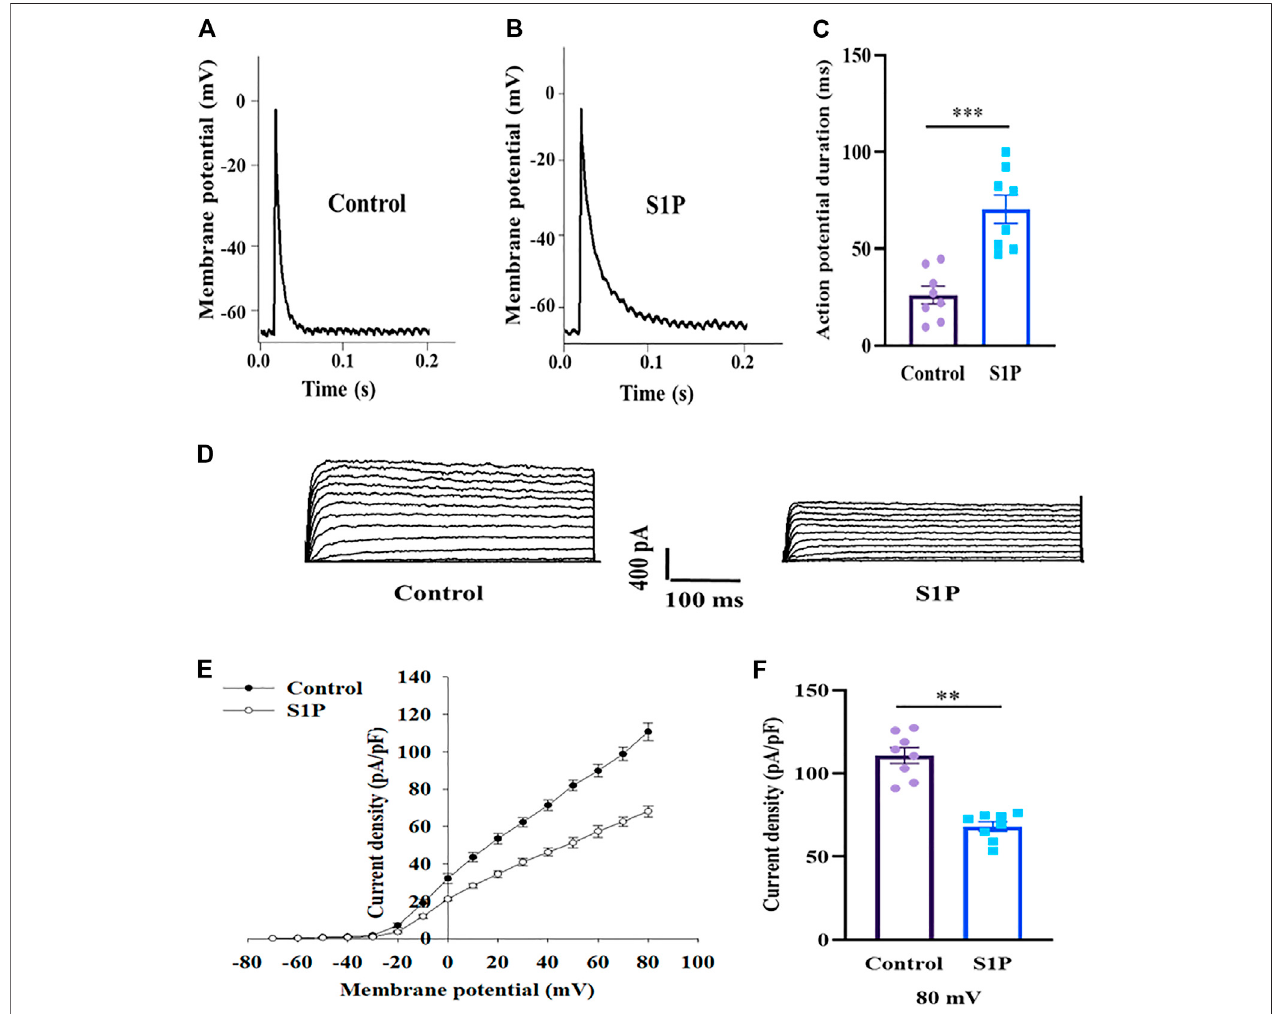
FIGURE 5 | Pancreatic β cells treated by sphingosine 1-phosphate (S1P) exhibited lengthened action potential duration (APD) and lower Kv currents. (A , B) Action potential waveforms of β cells treated without (A) and with (B) S1P (10 μ M). (C) Summary of the mean APDs ( n (cid:2) 8). (D) Representative current traces recorded in the absenceand presenceofS1P(10 μ M). (E) Current-voltage relationshipcurvesof β cellKvchannels. (F) SummaryofthemeancurrentdensitiesofKvchannelsat80 mV depolarization ( n (cid:2) 8). ** p < 0.01, *** p < 0.001; by unpaired two-tailed Student ’ s t test. The results represent by the mean ±